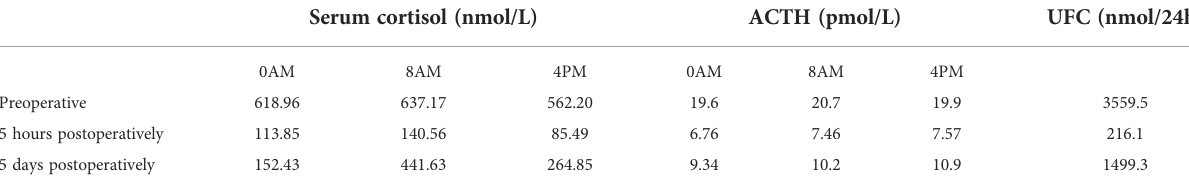
TABLE 1 Changes in indicators related to Cushing's syndrome in patients after